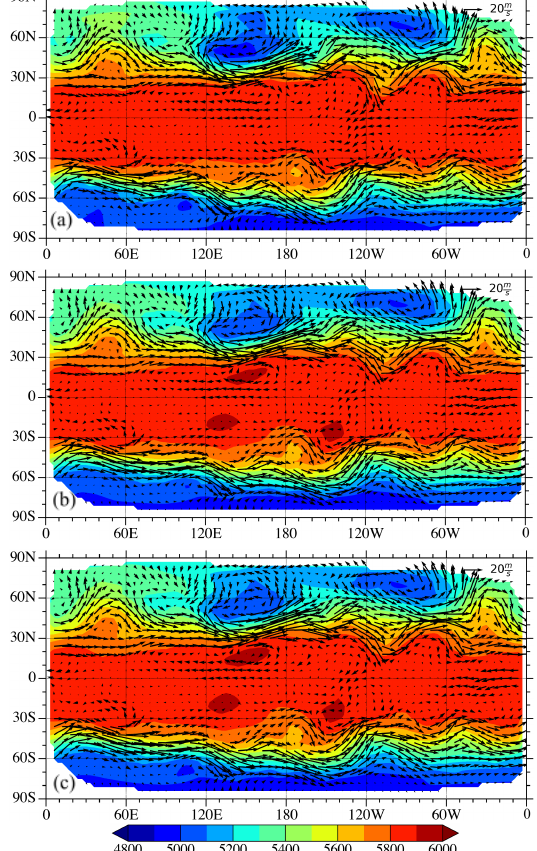
Figure 3. ( a ) The spatial distribution of the fields of height (shaded) and wind (vectors) at 00 UTC 1 January 2021. ( b , c ) The 12-h forecasts made by ( b ) the NN-based SW model and ( c ) MPAS-SW model.